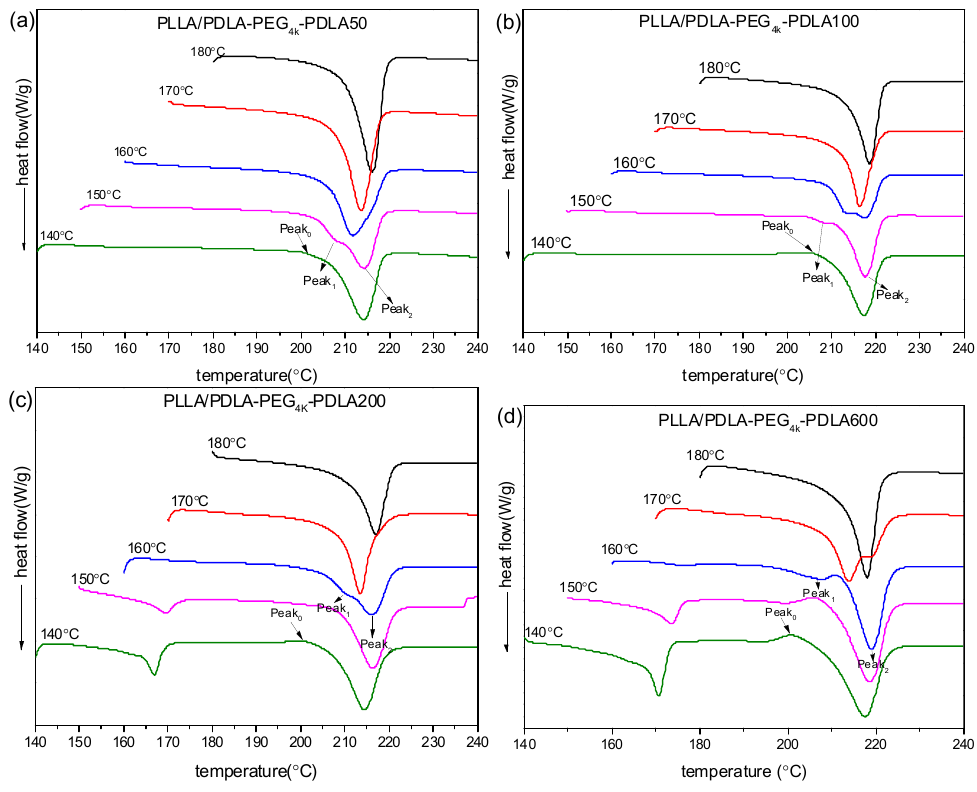
Figure 10. DSC heating curves of PLLA/PDLA-PEG 4k -PDLA with different PDLA blocks isothermally crystallized at different temperatures: ( a ) PLLA/PDLA-PEG 4k -PDLA50; ( b ) PLLA/PDLA-PEG 4k -PDLA100; ( c ) PLLA/PDLA-PEG 4k -PDLA200; ( d ) PLLA/PDLA-PEG 4k -PDLA600.